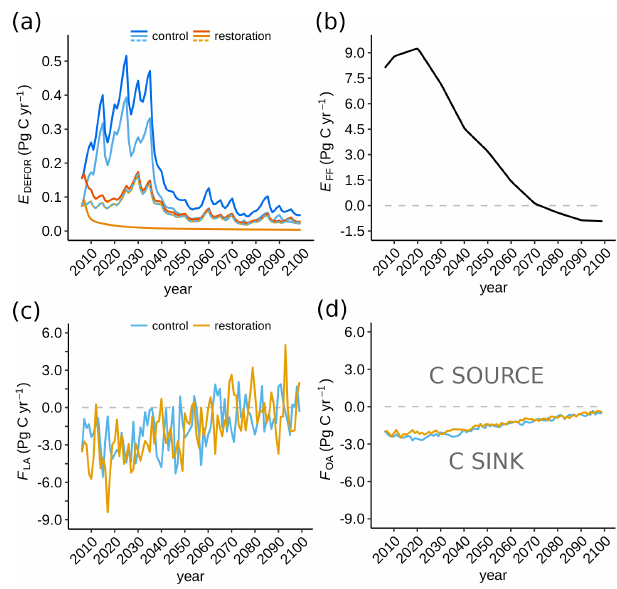
Figure 2. Modelled carbon emissions and fluxes (2006–2100CE) into the atmosphere for the control run (blues) and restoration simulation (oranges). (a) Deforestation emissions ( E DEFOR ); dark colours are global emissions, and light colours are the tropics and dashed lines are emissions outside the tropics. (b) Prescribed fos- sil fuel emissions ( E FF ) following RCP2.6 (Liddicoat et al., 2013). (c) Global land-to-atmosphere flux ( F LA ). (d) Global ocean-to- atmosphere flux ( F OA ). Negative values represent a carbon sink. Note the different vertical